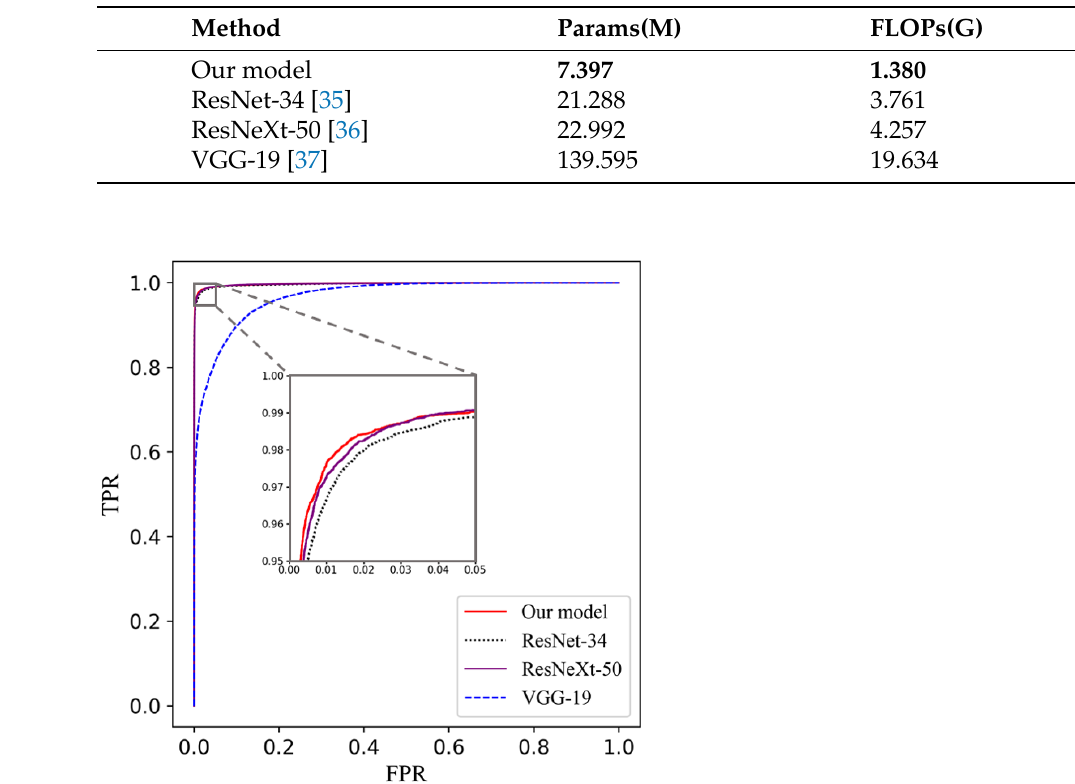
Table 6. The number of parameters and floating point operations (FLOPs) of the four models.